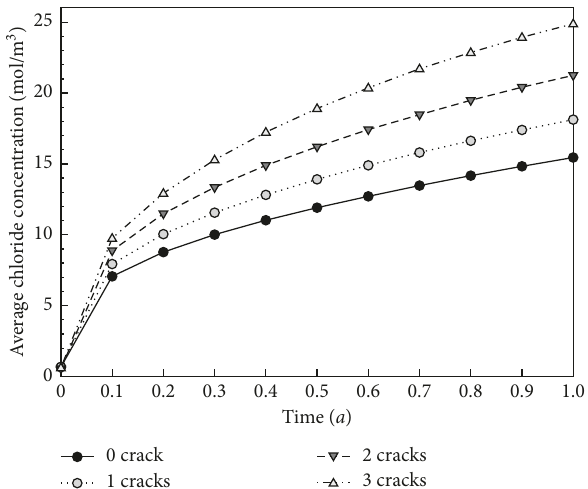
Figure 10: Average chloride concentration in concrete influenced by crack quantity.